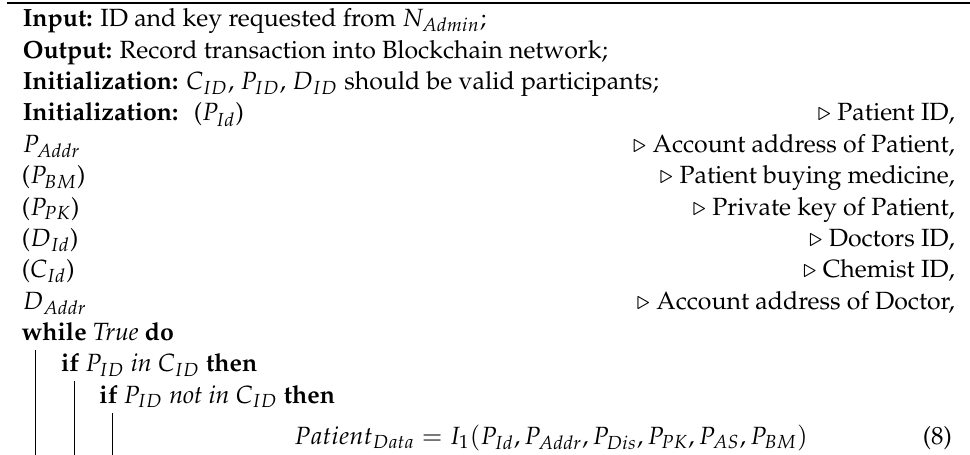
Algorithm 1: Algorithm for participant creating, initializing and querying health- care records (buying, selling medicine and appointment status